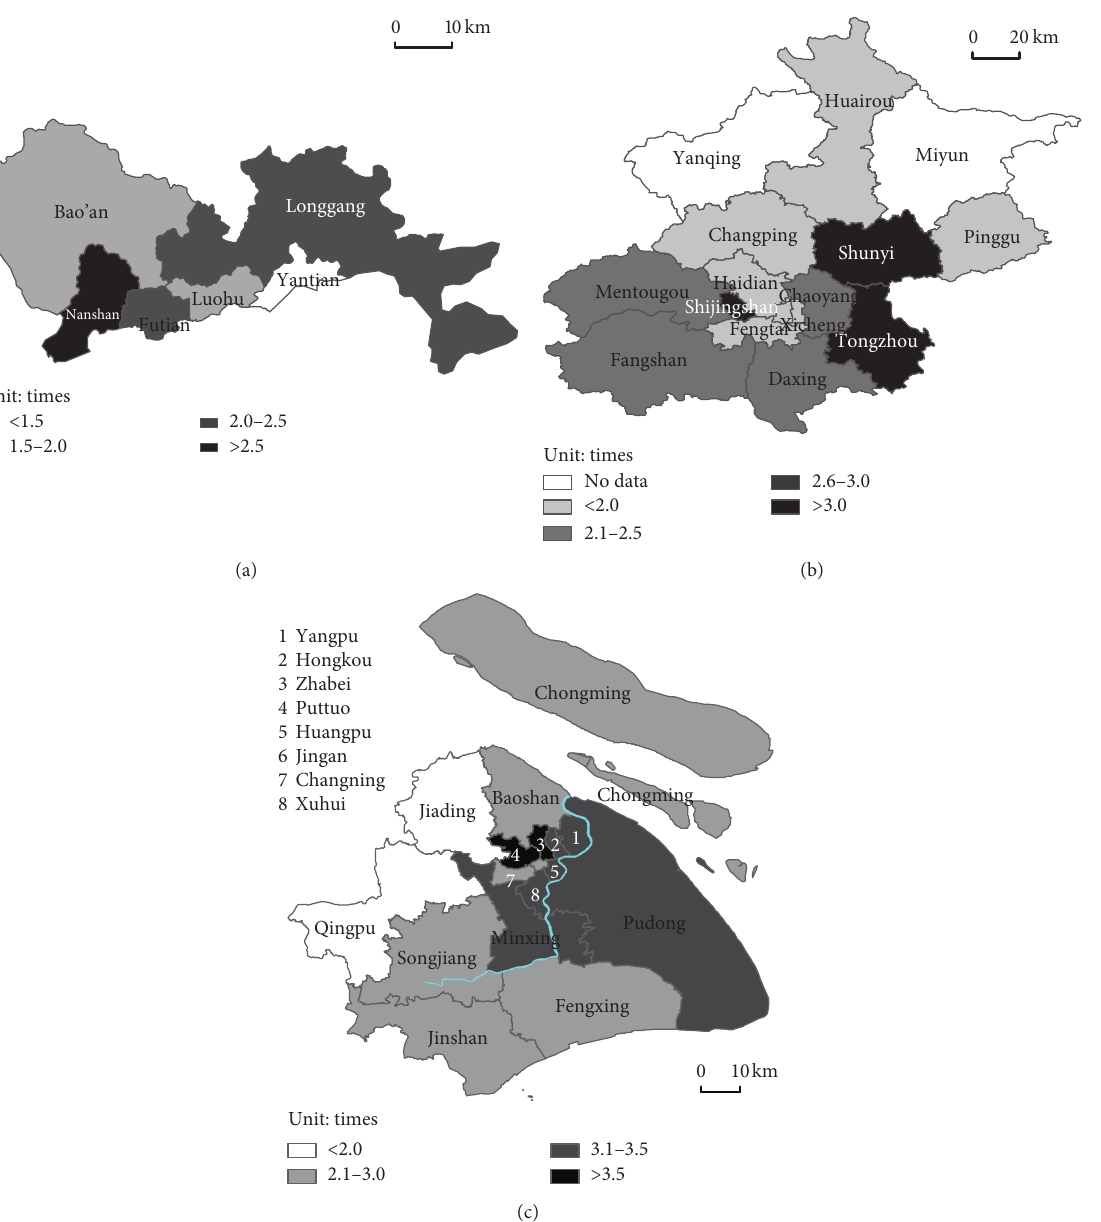
Figure 6: Spatial differences in the rise of housing prices in Beijing, Shanghai, and Shenzhen in 2009–2015. (a) Shenzhen. (b) Beijing. (c)